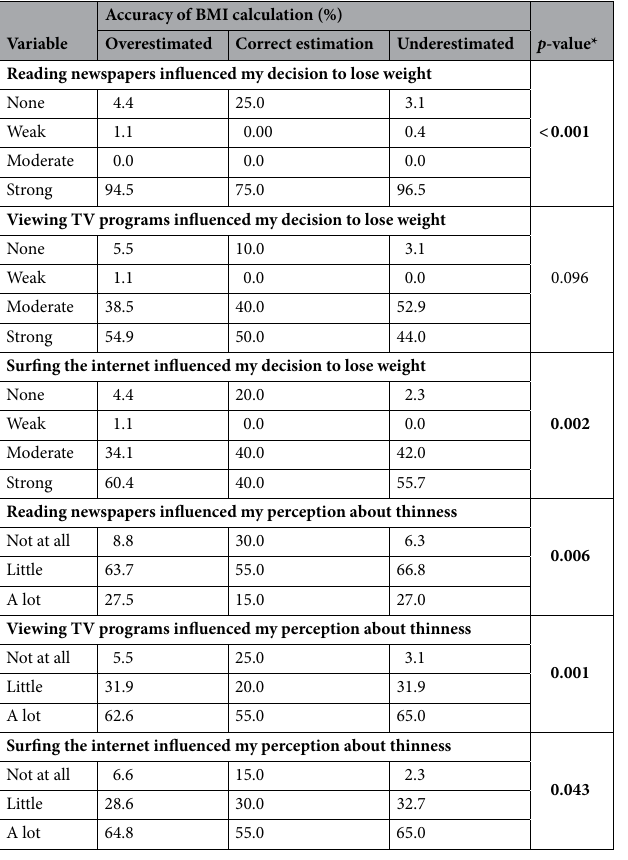
Table 4. Impacts of selected media-related variables on the accuracy of BMI calculation based on self-report body weight and height by the Kuwaiti adolescents. * Chi Squares tests for the proportion. Significant values are in